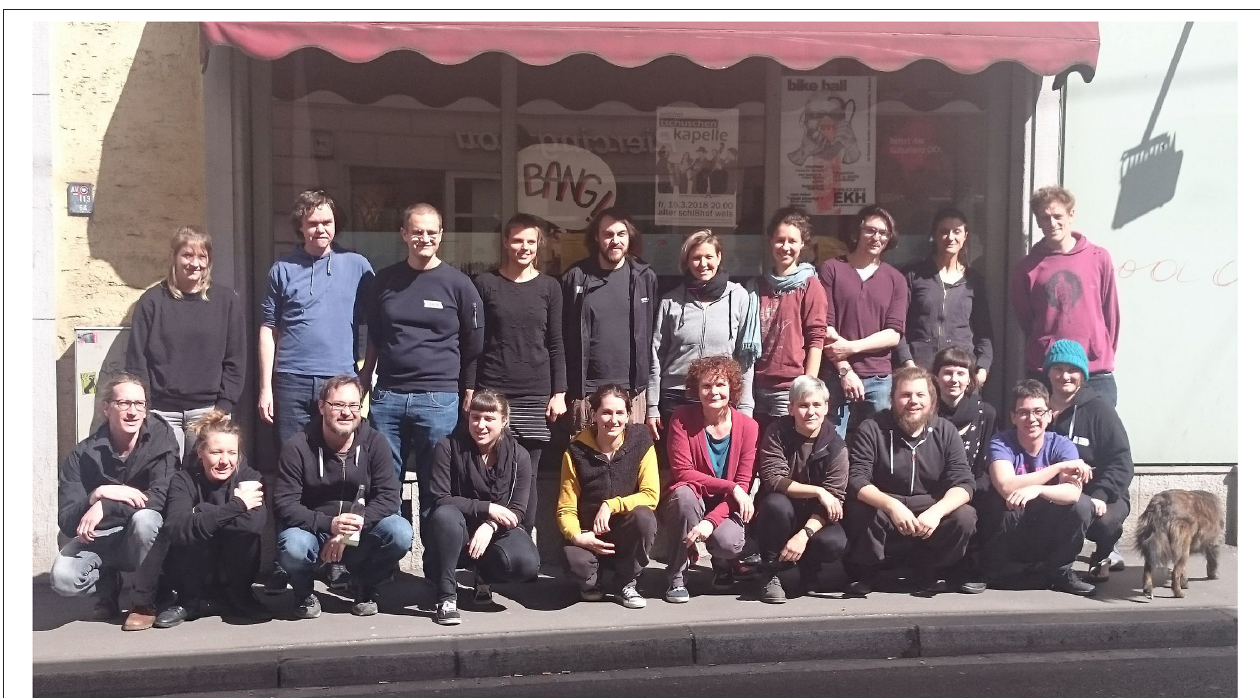
FIGURE 2 | habiTAT members meeting, 2018. Source: author’s